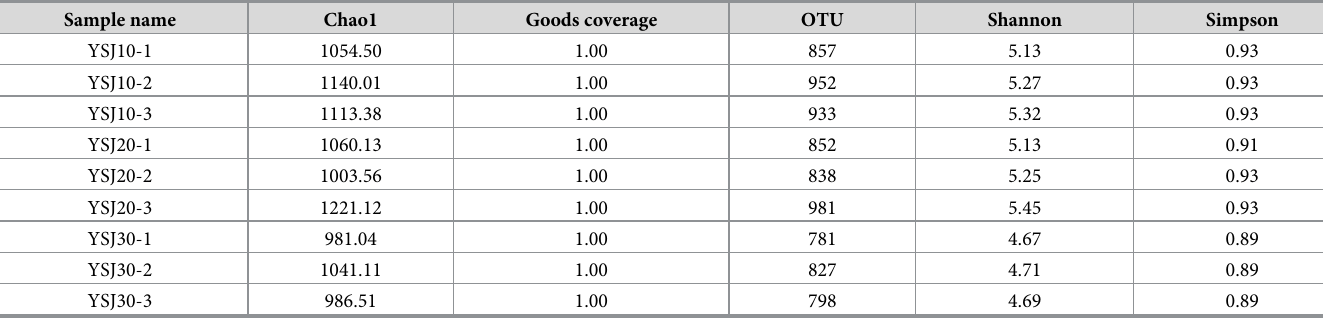
Table 2. Alpha diversity index statistics for the YSJ